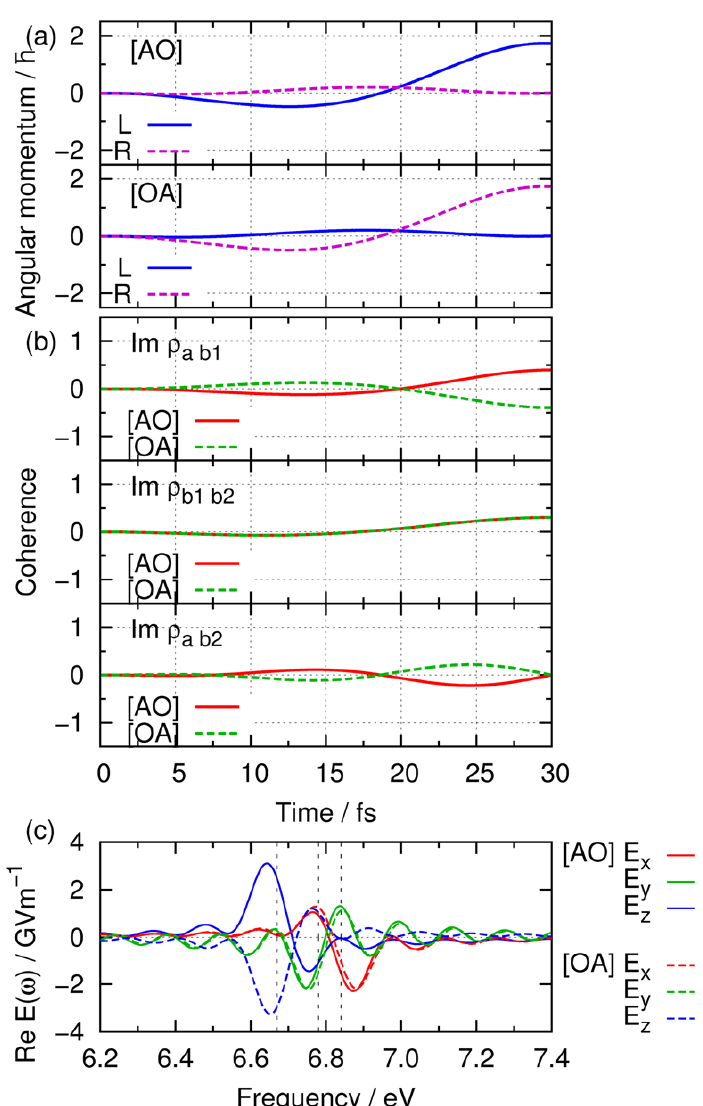
Figure 15. Results of quantum localization of π-electron rotations for the target [AO] and for the target [OA]. ( a ) Calculated time-dependent π-electron angular momenta l L ( t ) (blue solid line) and l R ( t ) (purple dashed line). ( b ) Imaginary parts of electronic coherences, ρ ab 1 ( t ), ρ b 1 b 2 ( t ), and ρ ab 2 ( t ). ( c ) Real parts of the optimal electric field in the frequency domain. Results of the [AO] ([OA]) target are shown in solid (dashed) lines. Reprinted from [91] with permission of the American Chemical Society.